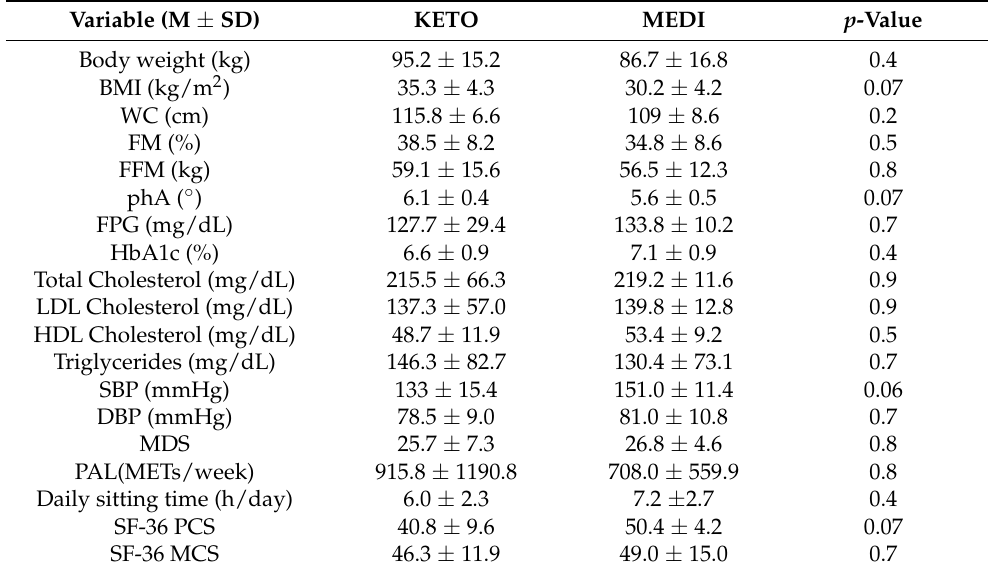
Table 1. Anthropometric, metabolic, lifestyle, and health status in KETO and MEDI groups at baseline. Variable (M ± SD) KETO MEDI p